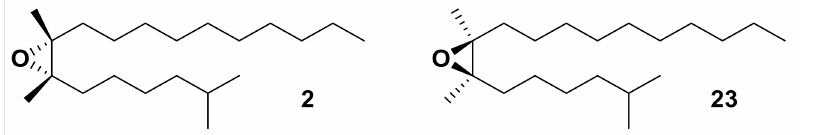
Figure 6. The chemical structures of (7 R ,8 S)- (+)-disparlure 2 and ( 7 S ,8 R)- ( − )-disparlure 23